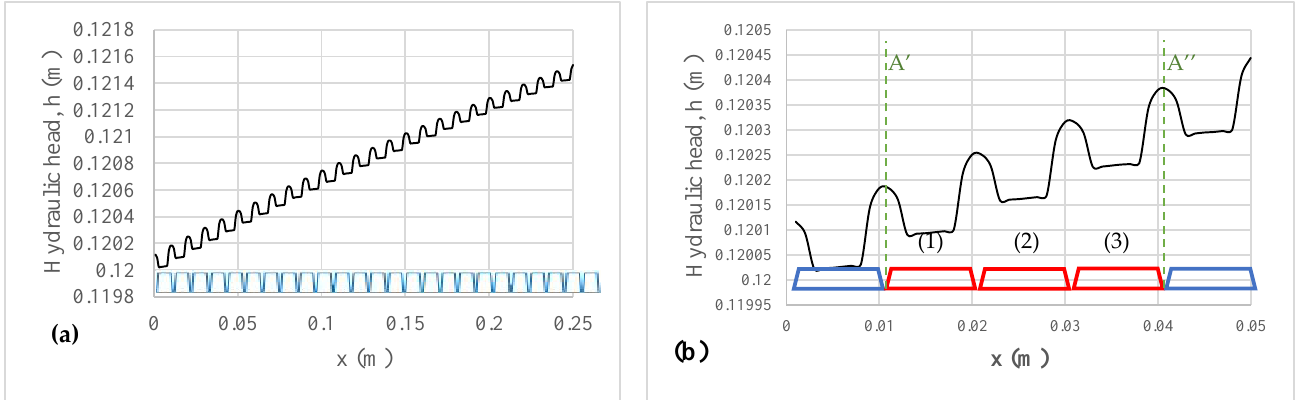
Figure 10. ( a ) . Distribution of hydraulic head in the gravel portion (x = 0 to 0.25 m), In ( b ), a zoomed visualization of the change in the hydraulic head from x − 0 to 0.05 m in the scale of the gravel piece (10 mm) (base case).